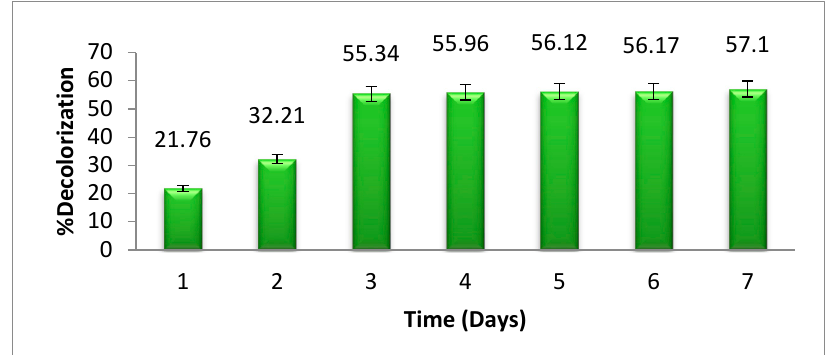
Figure 8. Effect of time in days on % degradation of methyl orange.